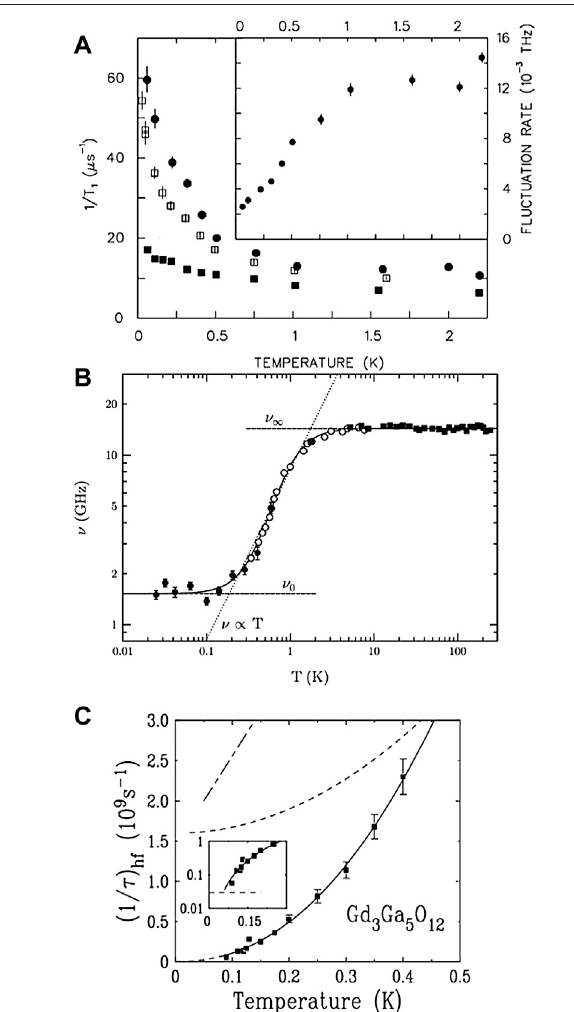
FIGURE 10 | (A) The temperature dependence of the root-exponential muon spin relaxation rate 1/T1 in GGG. The fi lled circles and squares are for single crystal GGGin fi eldsof0.0011and 1 T, respectively. The open squares are for GGG powder in a small fi eld of 0.005 T. The inset shows the temperature dependence of the Gd spin fl uctuation rate [23]. (B) The inferred fl uctuation rate, derived from muon spin relaxation measurements, as a function of temperature [24]. (C) Thermal variation of the fl uctuation rate of the correlated Gd 3+ moments in GGG, obtained from the 155 Gd Mssbauer data (black squares). Inset: Low temperature behavior (same units as the main fi gure), where the horizontal dashed line de fi nes the lower limit of the 155 Gd Mossbauer frequency window. The chain and dashed lines schematically representthedatafromthemuonspinrotationmeasurementsin[23,24].[25].